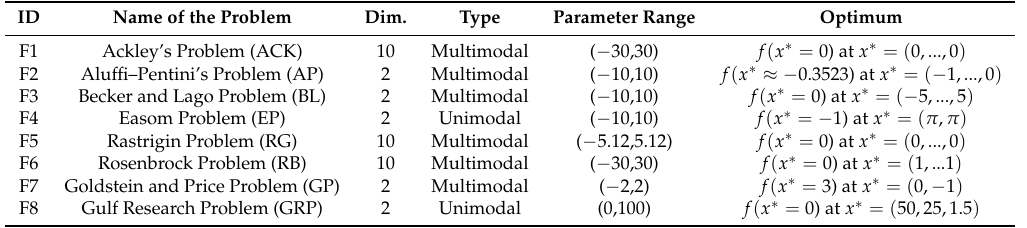
Table 1. Benchmark function